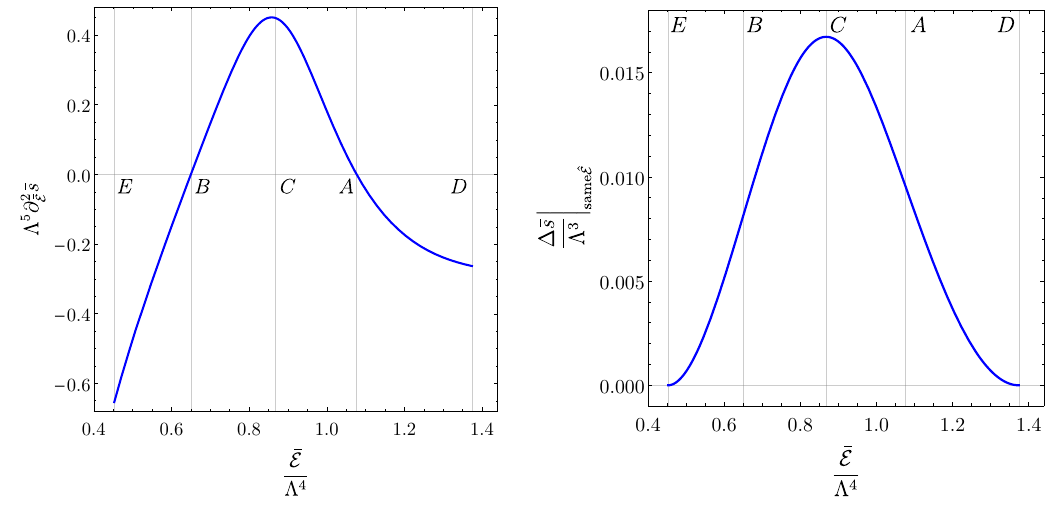
(ˆ Figure 6 . (Left) Second derivative ˆ s 00 E ) of the entropy density with respect to the energy den- sity, showing the convexity/concavity properties discussed in the text. (Right) Difference between the average entropy density of the phase-separated configurations and the entropy density of the homogeneous solutions, showing that the former are preferred in the region between A and B